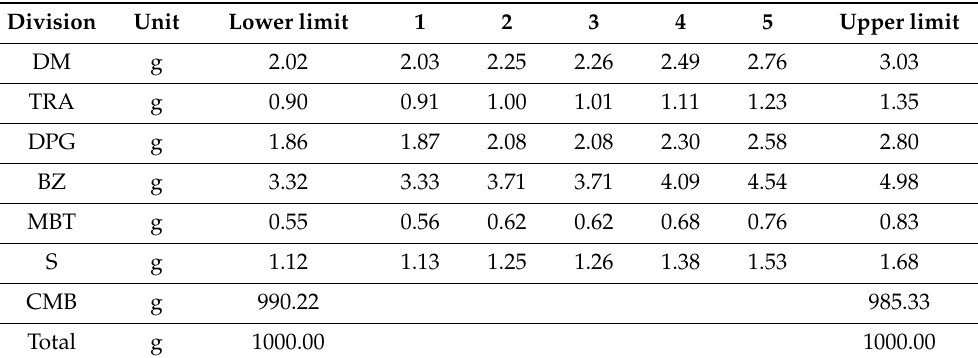
Table 1. Experimental design of